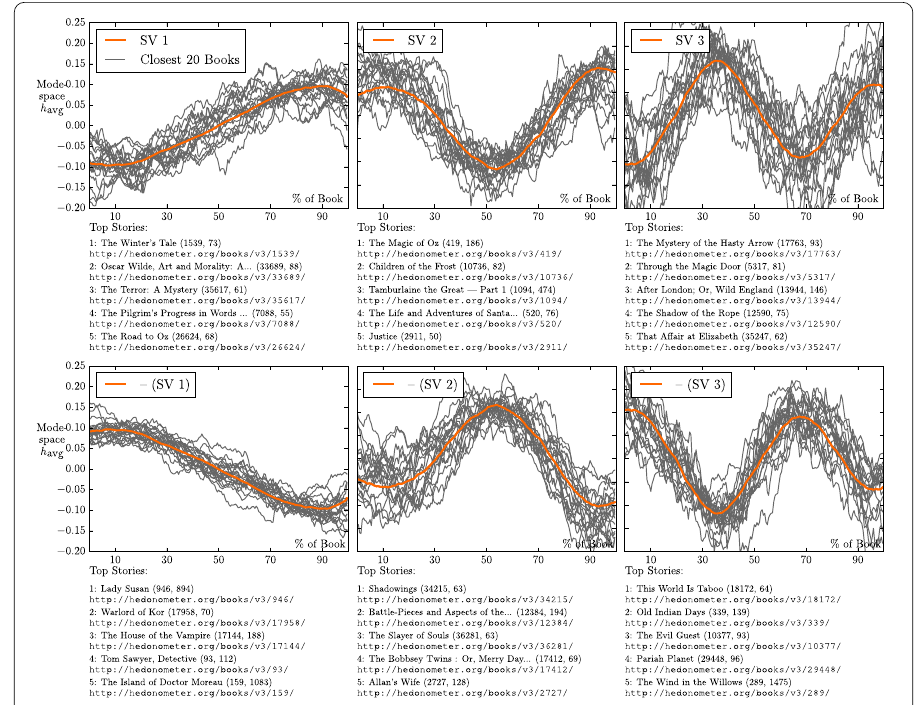
Figure 4 First 3 SVD modes and their negation with the closest stories to each. To locate the emotional arcs on the same scale as the modes, we show the modes directly from the rows of V T and weight the emotional arcs by the inverse of their coefficient in W for the particular mode. The closest stories shown for each mode are those stories with emotional arcs which have the greatest coefficient in W . In parentheses for each story is the Project Gutenberg ID and the number of downloads from the Project Gutenberg website, respectively. Links below each story point to an interactive visualization on http://hedonometer.org which enables detailed exploration of the emotional arc for the